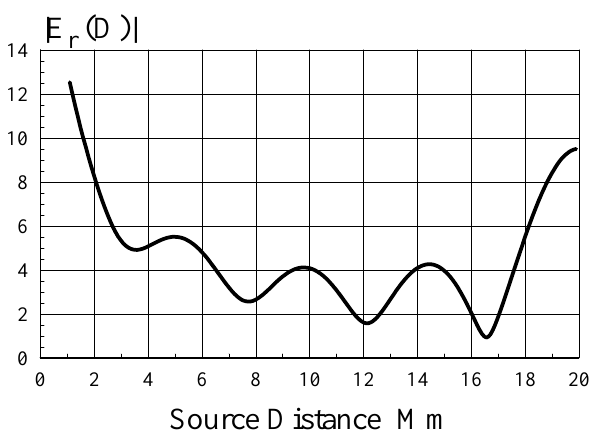
Fig. 3. Distance dependence of the amplitude of the vertical electric field component at the frequency of